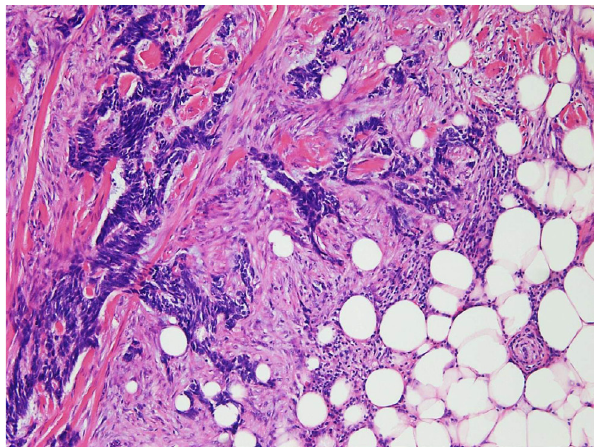
Figure 3. Right flank excision demonstrates infiltrative cords and strands of basaloid cells in a desmoplastic stroma characteristic of infiltrative type of BCC (hematoxylin-eosin stain, original magnification